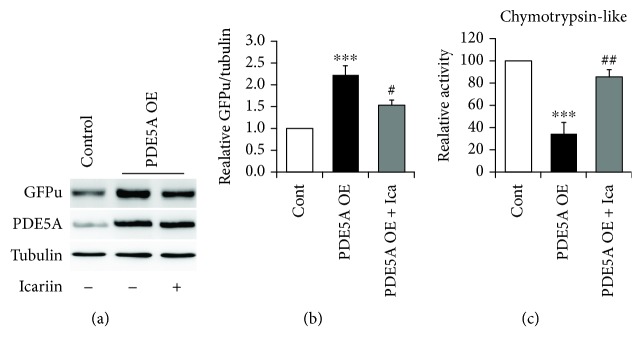
Effects of PDE5 inhibitor icariin (Ica) on proteasome activity in PDE5A-overexpressed C2C12 myotubes. (a) Representative western blots showing the effects of icariin on the GFPu protein levels; (b) quantification of the GFPu protein levels in (a); (c) effects of icariin on the chymotrypsin-like activity of proteasome. N = 4. ∗∗∗P < 0.001 vs. the control group; #P < 0.05, ##P < 0.01 vs. the PDE5A-overexpression (OE) group.